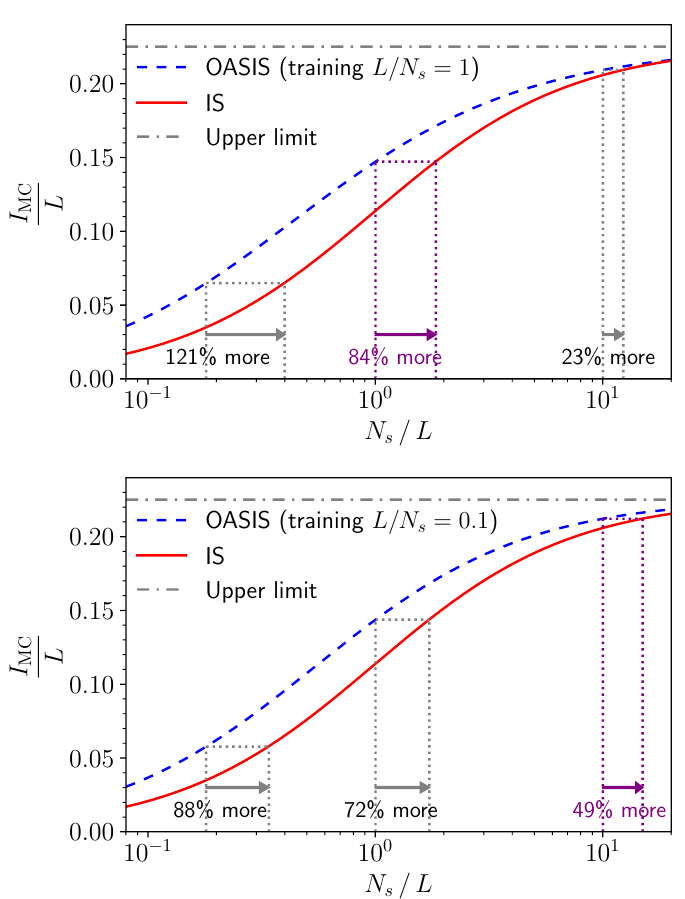
/ L for the OASIS-trained (blue dashed curve) Figure 6: Dependence of on N s I MC and IS (red solid curve) sampling distributions. In the top (bottom) panel, the OA- = 1 ( L / N = 0.1). The horizontal SIS sampling distribution was trained at L / N s s arrows indicate the percent reduction in the simulation requirements at three repre- / L . In both panels, the gray dot-dashed line indicates sentative values of the ratio N s the theoretical upper bound obtained in the infinite simulated statistics